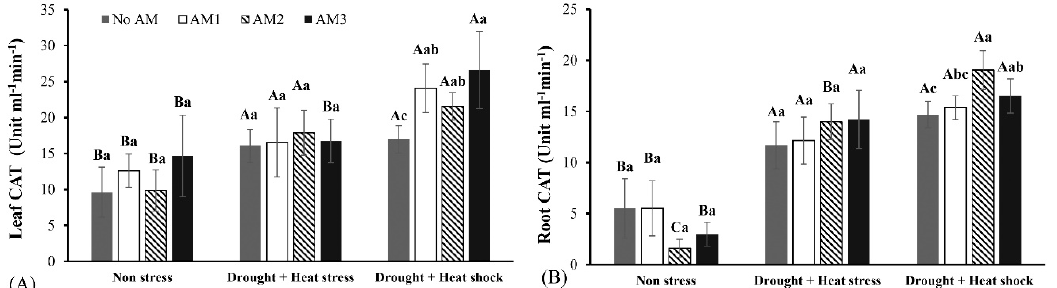
Figure 4. The activity of catalase (CAT) in leaves ( A ) and roots ( B ) of non-inoculated plants (No AM) and plants inoculated by R. irregularis (AM1), F. mosseae (AM2), or F. coronatum (AM3) subjected to non-stress (NoS), drought + heat stress (D + H), and drought + heat shock (D + HS). Each bar represents the mean and standard deviation (n = 4). Different minuscules indicate significant differences among treatments under the same conditions (no stress, drought + heat stress, or drought + heat shock) by Duncan’s post hoc test at p ≤ 0.05. Different capital letters indicate significant differences of the same treatments (No AM, R. irregularis, F. mosseae, or F. coronatum ) under different conditions (no stress, drought + heat stress, and drought + heat shock) by Duncan’s post hoc test at p ≤ 0.05. Leaf glutathione-S-transferase activity was significantly increased in plants inoculated with F.